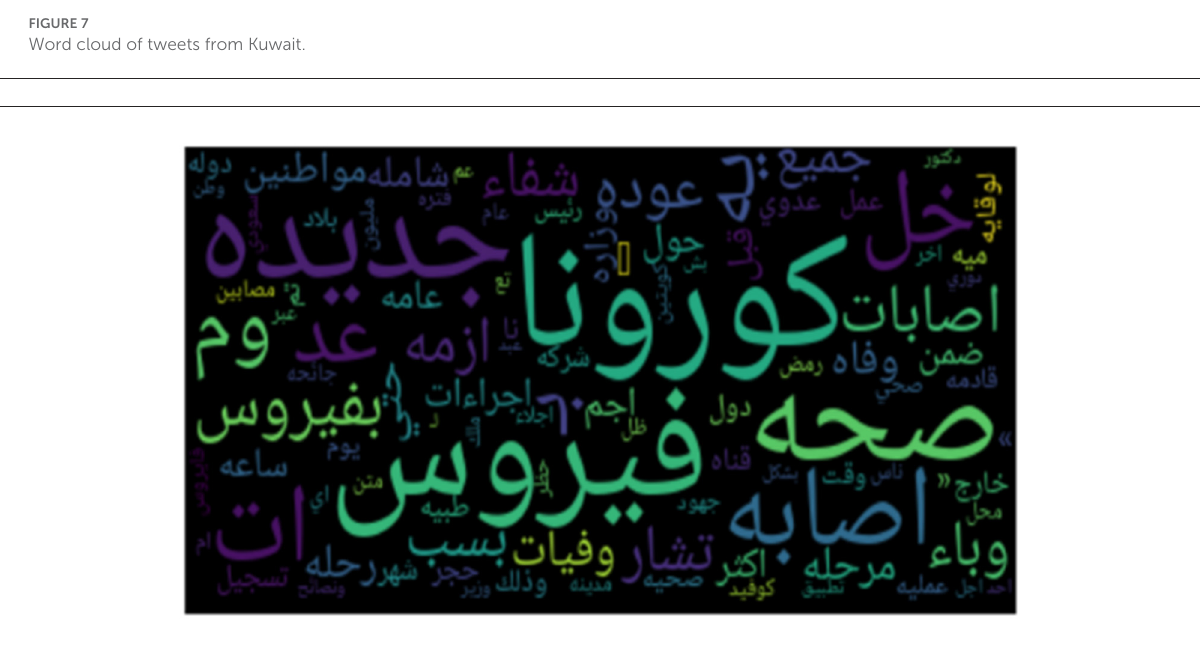
FIGURE8 The word cloud of Bahrain.